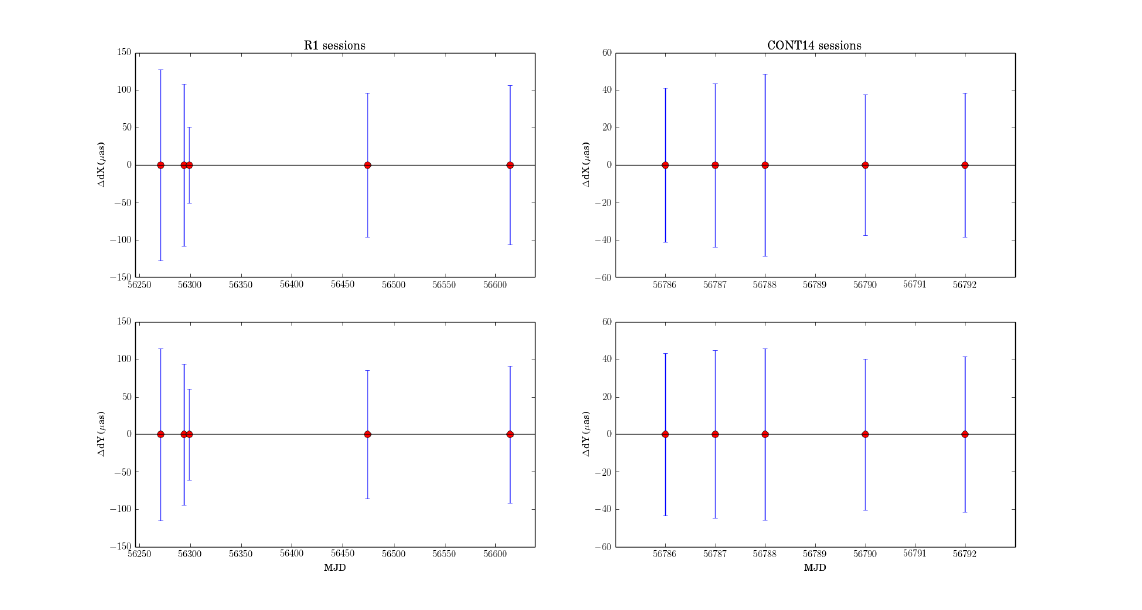
Figure 9: The differences in nutation components dX (top row) and dY (bottom row) from IVS-R1 (left column) and CONT14 (right column) sessions, when either On or Od data are used in the